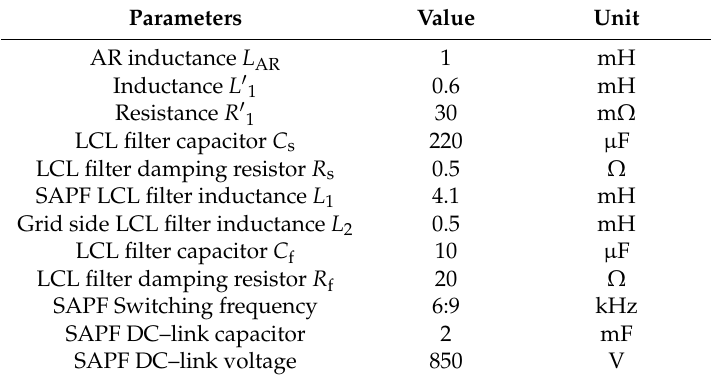
Table 2. Parameters of the advanced universal power quality conditioning system (AUPQS).